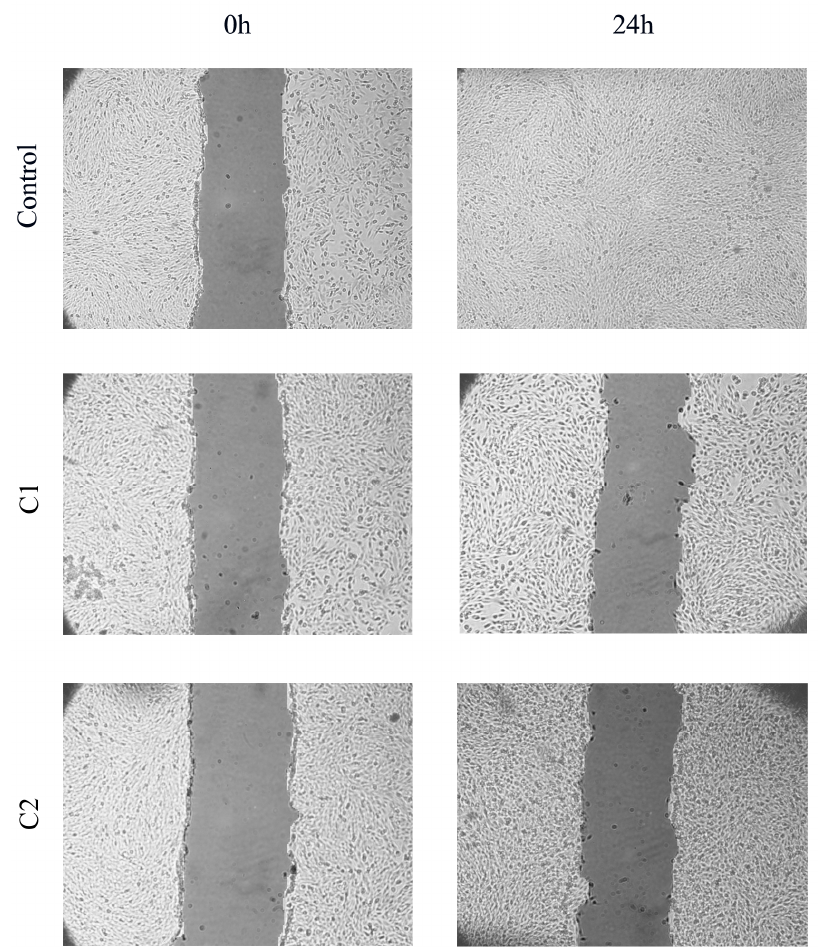
Figure 8. Representative photomicrographs of scratch assay before and after 24 h treatments of EA.hy926 cells with IC 20 concentrations of compounds C1 and C2.